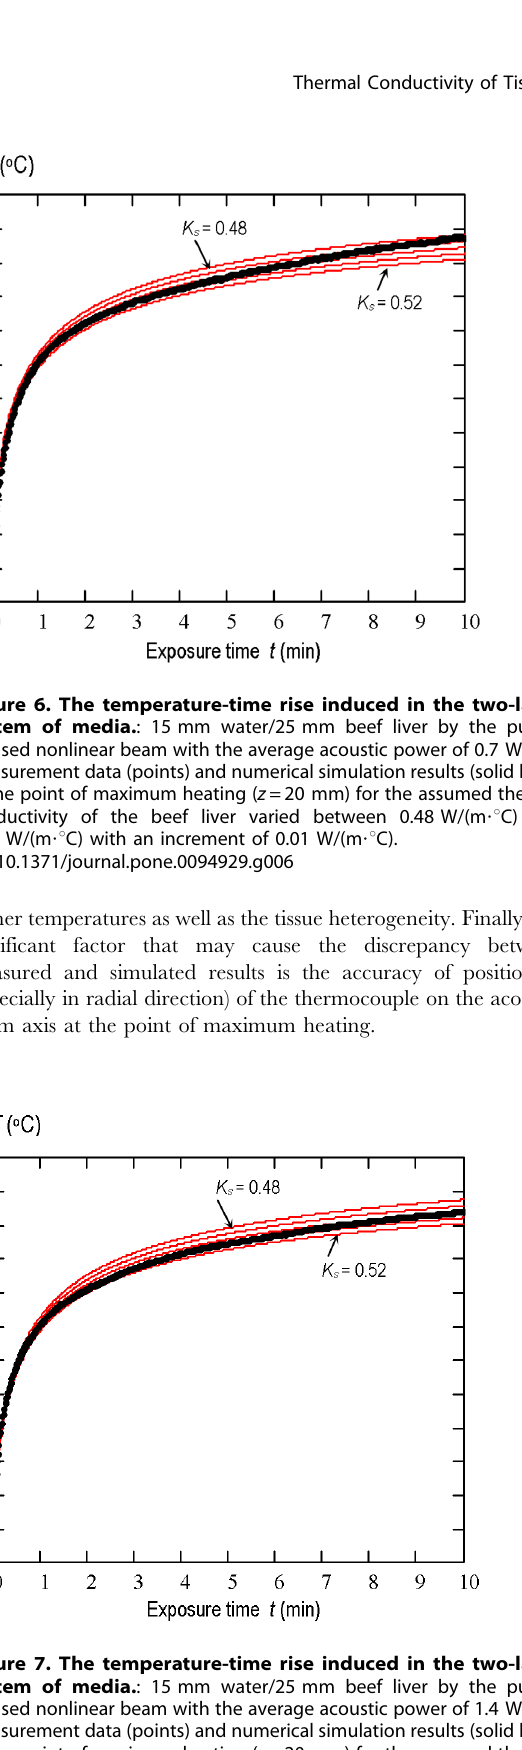
Figure 7. The temperature-time rise induced in the two-layer system of media. : 15 mm water/25 mm beef liver by the pulsed focused nonlinear beam with the average acoustic power of 1.4 W. The measurement data (points) and numerical simulation results (solid lines) at the point of maximum heating ( z =20 mm) for the assumed thermal conductivity of the beef liver varied between 0.48 W/(m ? u C) and 0.52 W/(m ? u C) with an increment of 0.01 W/(m ? u C).